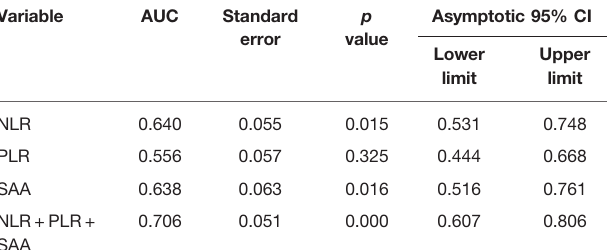
TABLE 3 | Value of serum NLR, PLR and SAA levels in predicting patients with stage III CRC. Variable